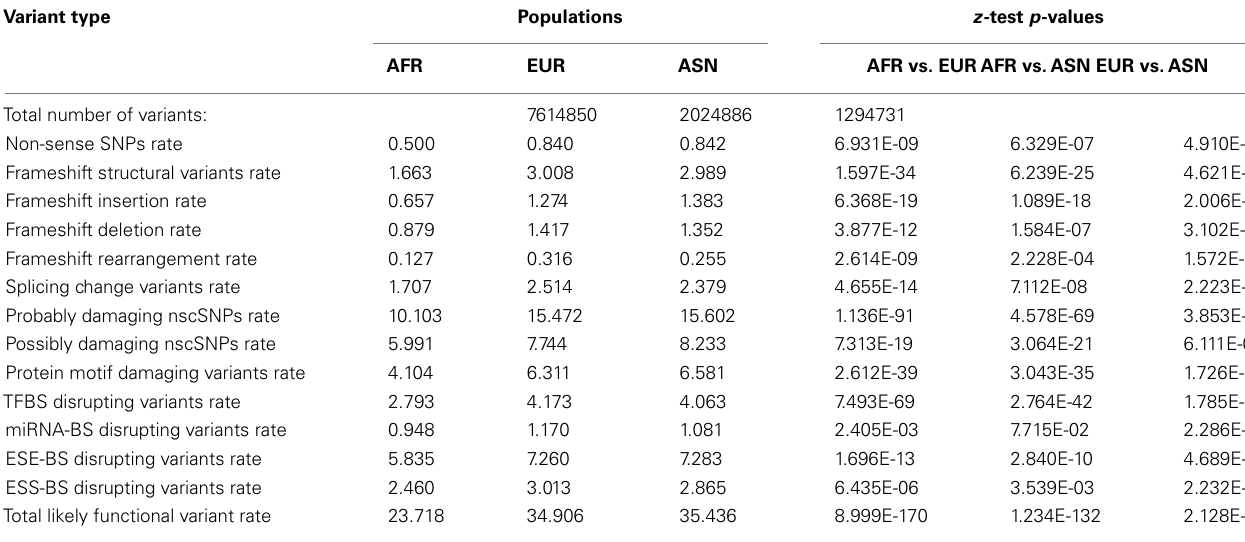
Table 3 | Frequency and rates ( × 10000) of population-specific variant types forAfrican (AFR), European (EUR), andAsian (ASN)